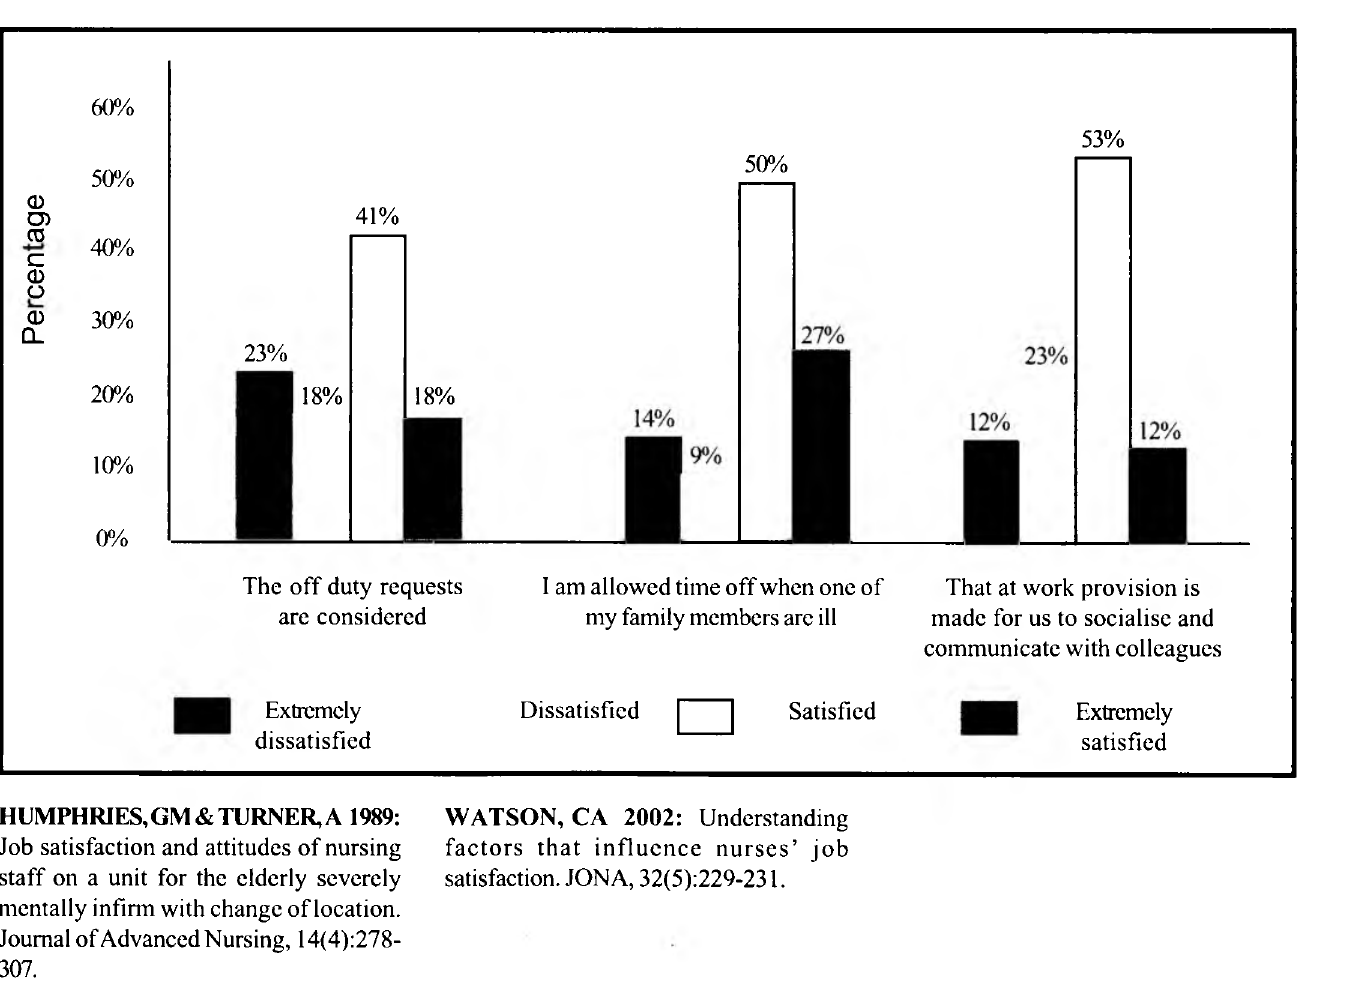
Figure 9: Scheduling